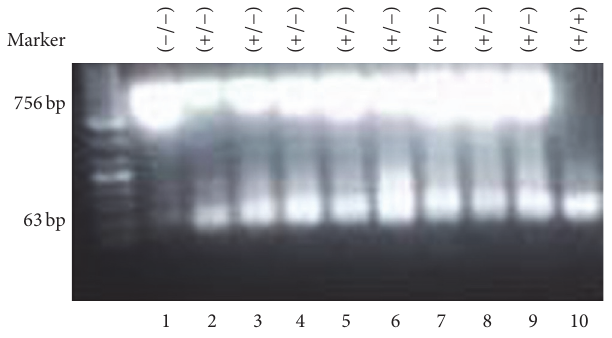
Figure 6: Lane 1 ( − / − ) is homozygotes of UT gene knockout (KO group) genotype mouse; lanes 2–9 (+/ − ) are heterozygotes of UT gene knockout mice; lane 10 (+/+) is wild type (WT)